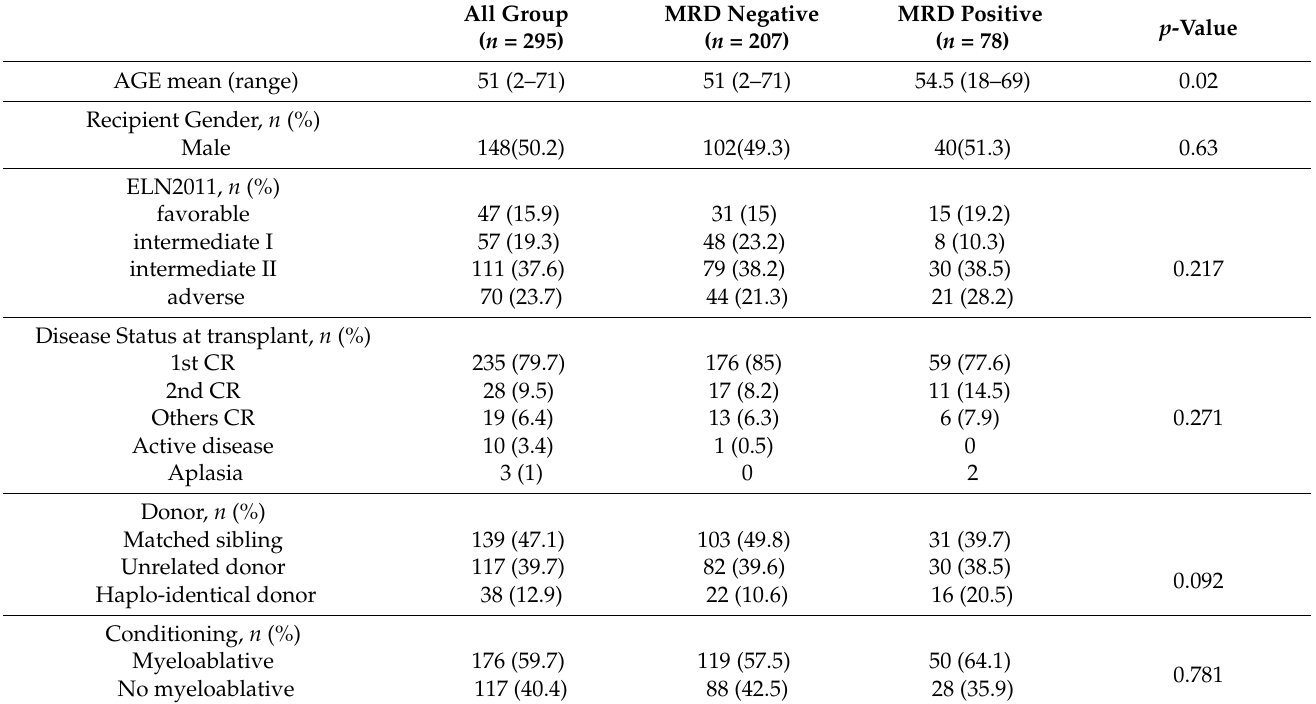
Table 1. Characteristics of the patients according to MRD before